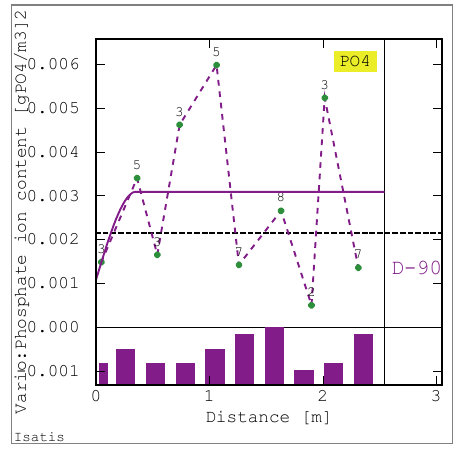
Fig. 22. Directional semivariogram (D-90) of phosphate anion 3 PO  content [g 3 PO  /m 3 ] 2 4 4 in underground water in Kłodzko intake area; 14